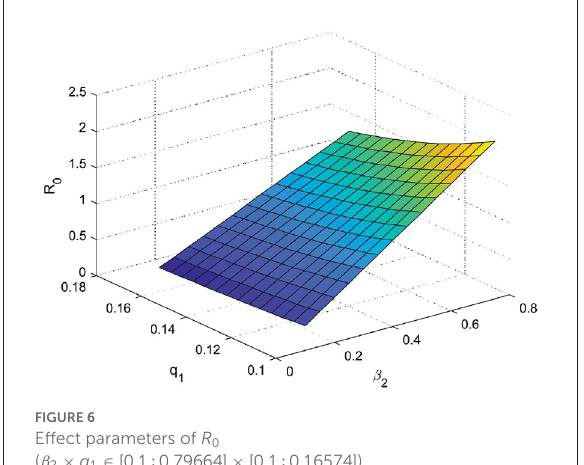
FIGURE6 Effect parameters of R 0 ( β 2 × q 1 ∈ [0.1 : 0.79664] × [0.1 : 0.16574]).